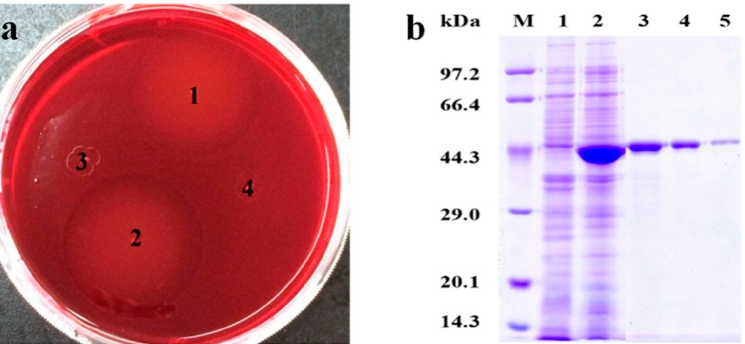
Figure 5. The activity analysis of positive colonies dyed by Congo-red and SDS-PAGE analysis. ( a ) 1 and 2: Escherichia coli BL21(DE3) harboring pET-28a (+)- Man26E ; 3: Escherichia coli BL21(DE3) harboring pET-28a (+); 4: Escherichia coli BL21(DE3). ( b ) SDS-PAGE analysis. Lane M: Marker; Lane 1: Escherichia coli BL21(DE3) control; Lane 2: Escherichia coli BL21(DE3) harboring pET-28a (+)- Man26E Lane 3, Lane 4 and Lane 5: The purified Man26E.